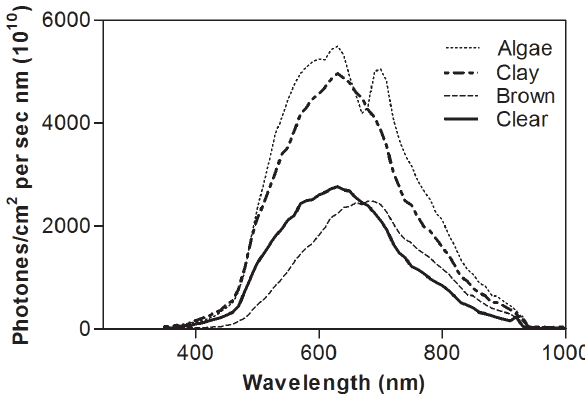
Figure 1. Spectral distribution of downwelling light in clear, algae, clay and humic brown water at 5.5 cm depth.